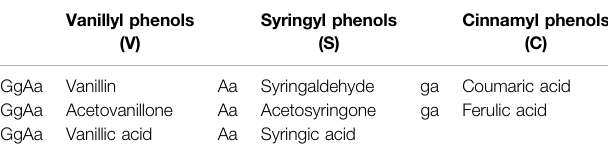
TABLE 2 | Lignin phenol oxidation products analyzed in this study. Codes indicate provenance as described by Hedges and Ertel (1982). G (cid:2) gymnosperms, woody tissue; g (cid:2) gymnosperms, non-woody tissue; A (cid:2) angiosperms, woody tissue; a (cid:2) angiosperms, non-woody